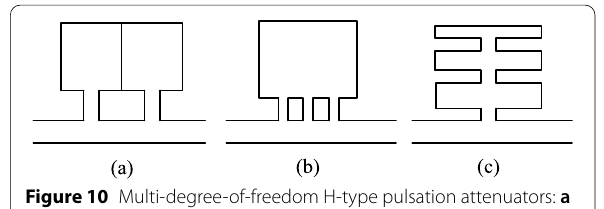
Figure 10 Multi-degree-of-freedom H-type pulsation attenuators: a parallel H-type, b composite H-type, c series H-type